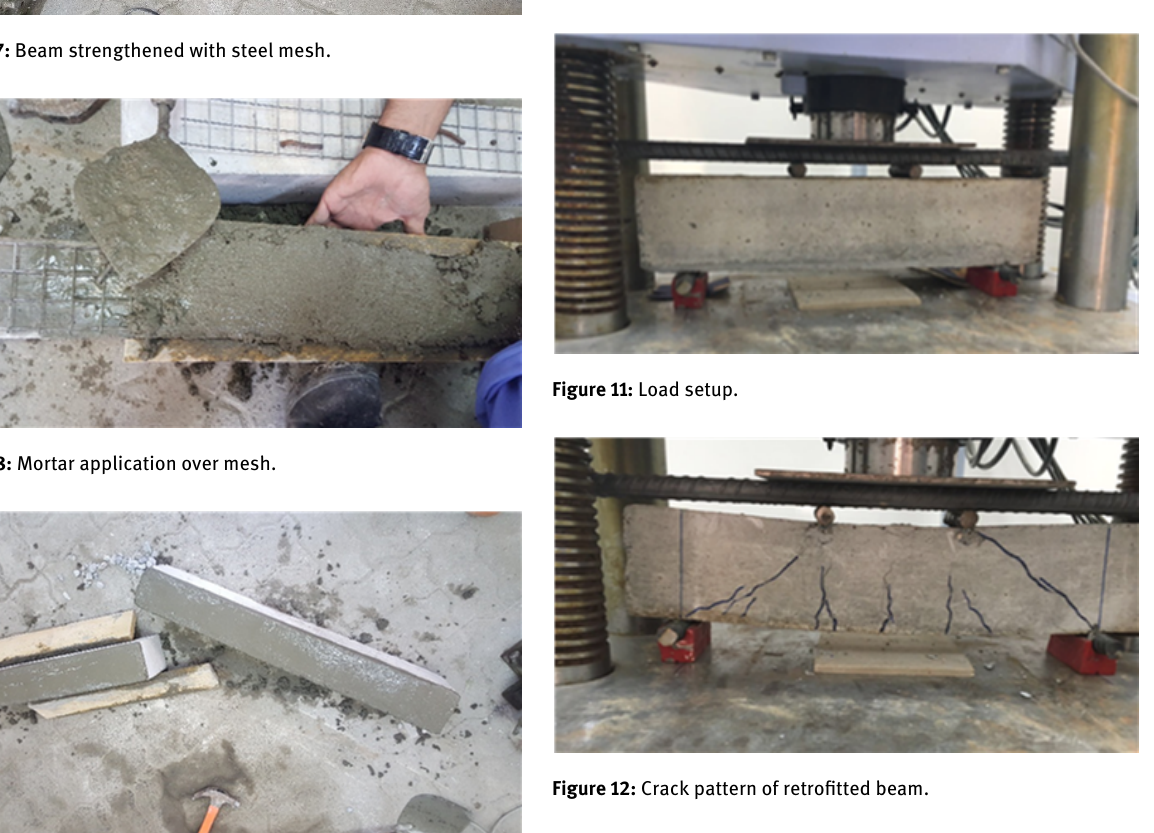
Figure 10: Test setup.